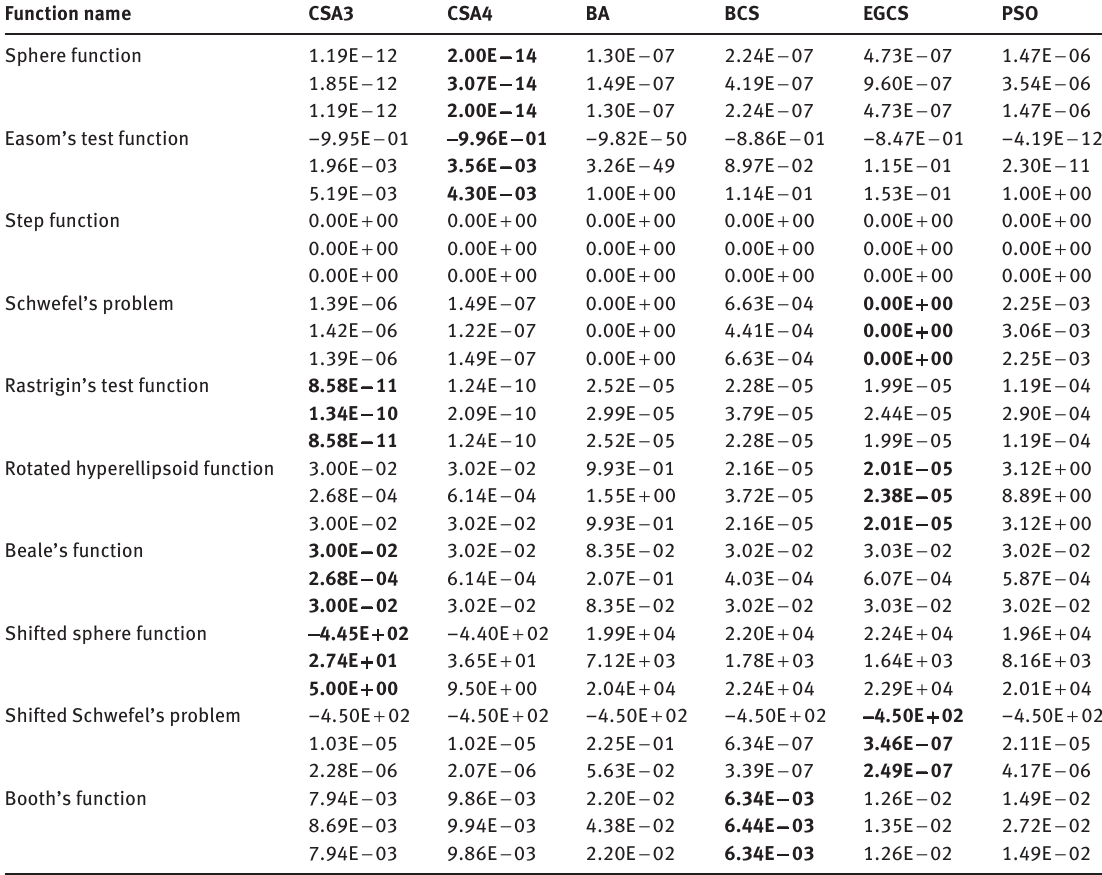
Table 10: Comparison Results of CSA3 and CSA4 to Four Other Optimization Algorithms. Function